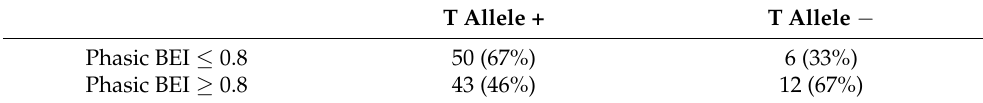
Table 4. Frequency of phasic BEI values depends on the presence of T allele in the studied locus. T Allele + T Allele − Phasic BEI ≤ 0.8 50 (67%) 6 (33%) Phasic BEI ≥ 0.8 43 (46%) 12